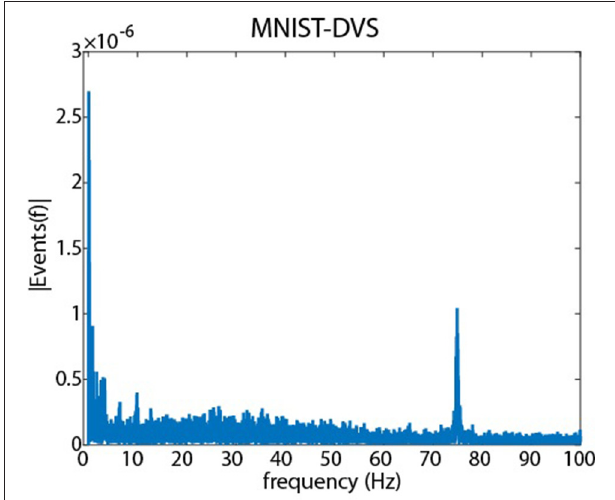
FIGURE 1 | A Fourier analysis of the MNIST-DVS dataset showing the amplitude of different temporal frequencies in the recordings. The 0Hz component has been removed, and the energy in the signal has been normalized to 1 by dividing by the l 2 norm. Clear peaks are observed at low frequencies due to the slowly varying motion of the digits on the monitor. A significant peak is observed at 75Hz due to the discontinuous motion presented to the sensor as a result of the 75Hz monitor refresh